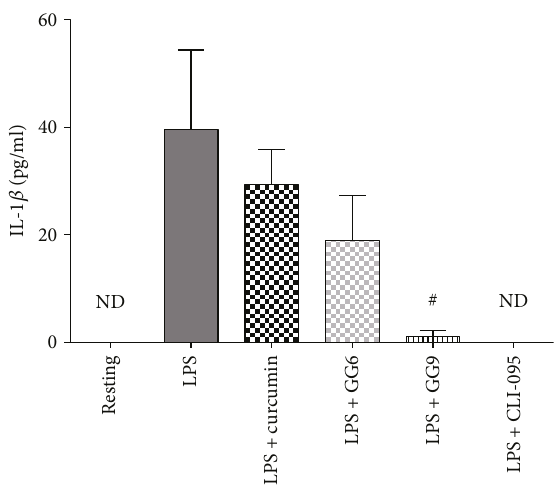
Figure 8: E ff ects of curcumin, GG6, GG9, and CLI-095 on IL-1 β release from LPS-stimulated human macrophages. After di ff erentiation, macrophages were pretreated with curcumin, GG6, GG9, and CLI-095 as indicated for 30 min followed by stimulation with 1 μ g/ml LPS for 24h in FBS-free RPMI. Supernatants were collected and analyzed for IL-1 β release by ELISA. Bar graph represents the mean ( ± SEM) of 3 independent experiments. # p < 0 05 versus